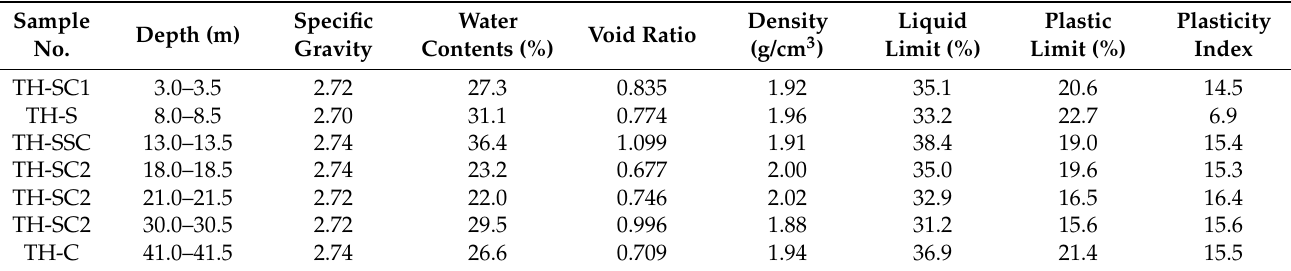
Table 1. Basic physical properties of samples obtained by laboratory tests.